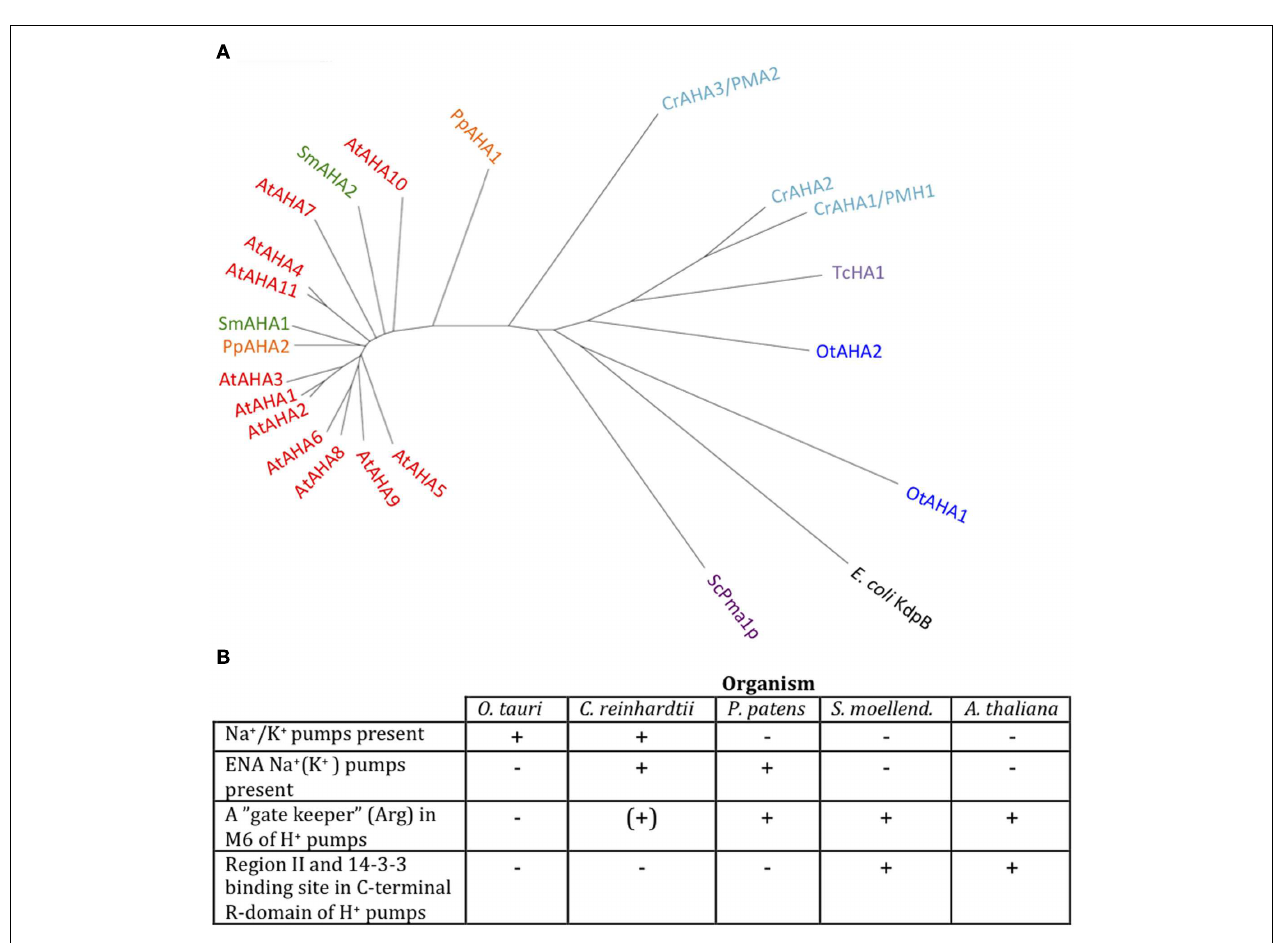
FIGURE 9 | Phylogenetic tree of P3ATPases (H + -pumps) (A) and table summarizing conserved features (B). Accession numbers for sequences are given in Table 2 . For comparison, the following outliers were included: a bacterial P1A ATPase E. coli KdpB (P03960), the S. cerevisiae pump ScPma1p (P05030), and the Trypanosoma cruzi pumpTcHA1